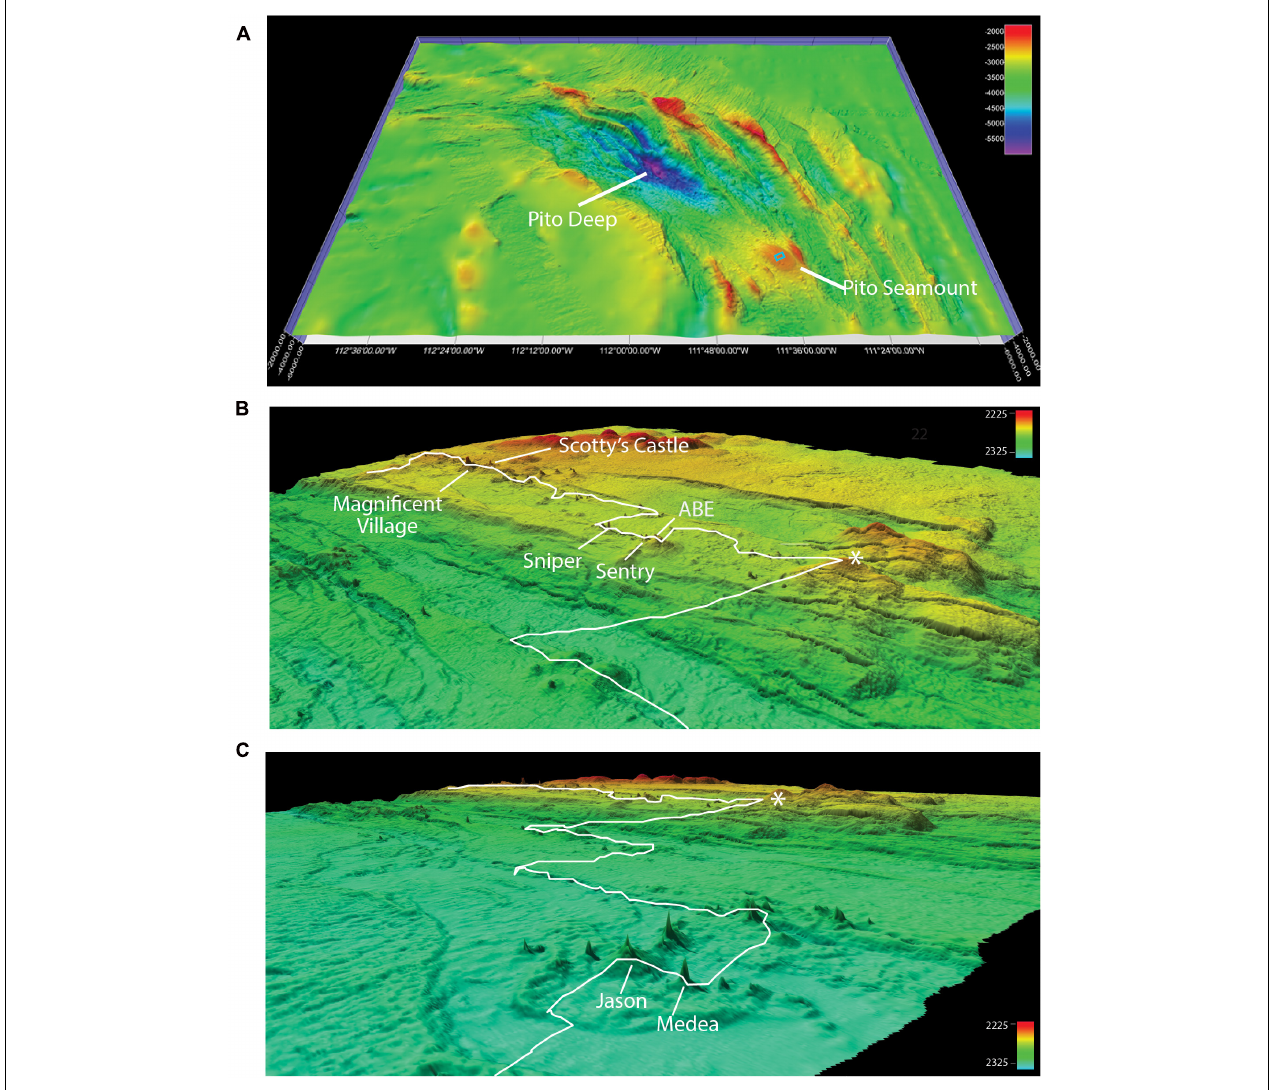
FIGURE 4 | Geomorphological context of the ROV Jason II Dive 961 transect. (A) Ship multibeam bathymetry (60-m resolution) from R/V Atlantis cruise 11–33 (2005) infilled with satellite-derived bathymetry to show the location of Pito Seamount and the study area detailed in (B,C) (blue rectangle) relative to Pito Deep. (B,C) Overlapping Fledermaus-rendered perspectives, Pito Seamount study site. Approximate location of ROV Jason II Dive 961 transect (white line) is overlain on high-resolution bathymetry (0.5–1 m resolution) collected during AUV Sentry Dive 427 at the summit of Pito Seamount. Asterisks in B and C mark the same geographical locale. Active hydrothermal vents visited during the transect are labeled (see also Table 1 ). All images produced in Fledermaus v